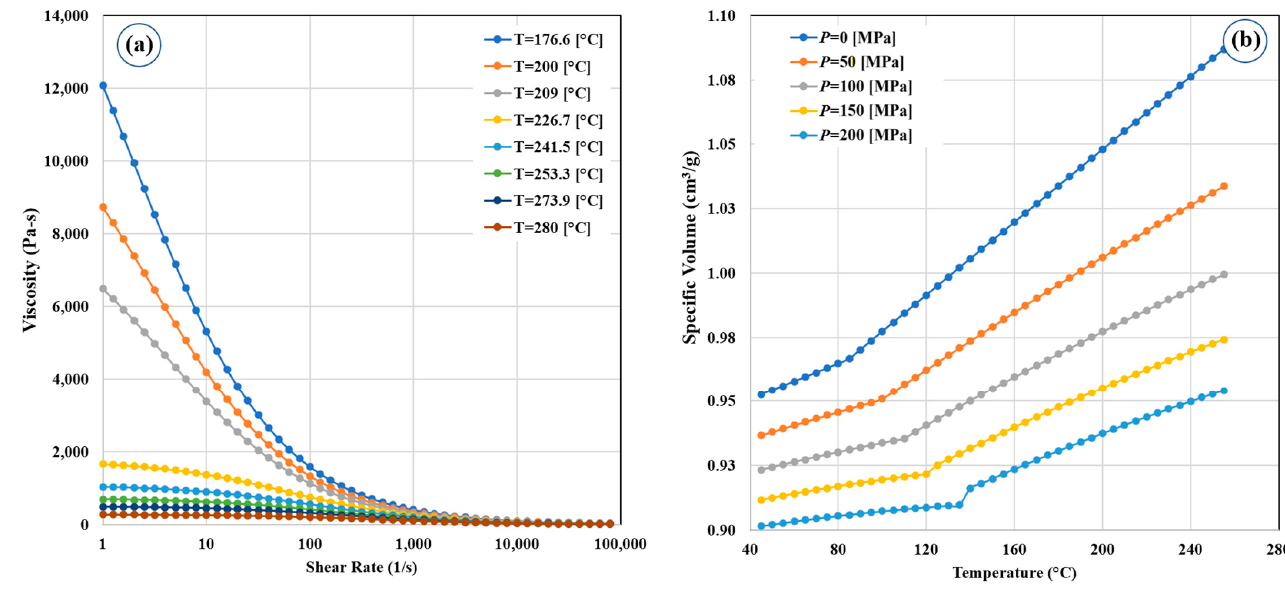
Figure 2. ( a ) Viscosity–shear rate and ( b ) Specific volume of